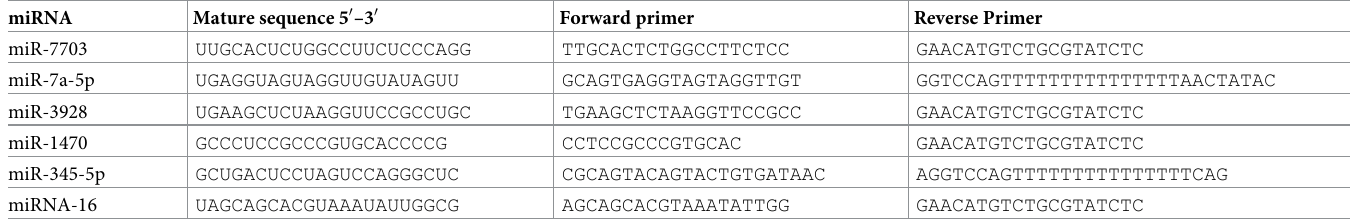
Table 2. Sequence, genomic location and primers of novel miRNAs.